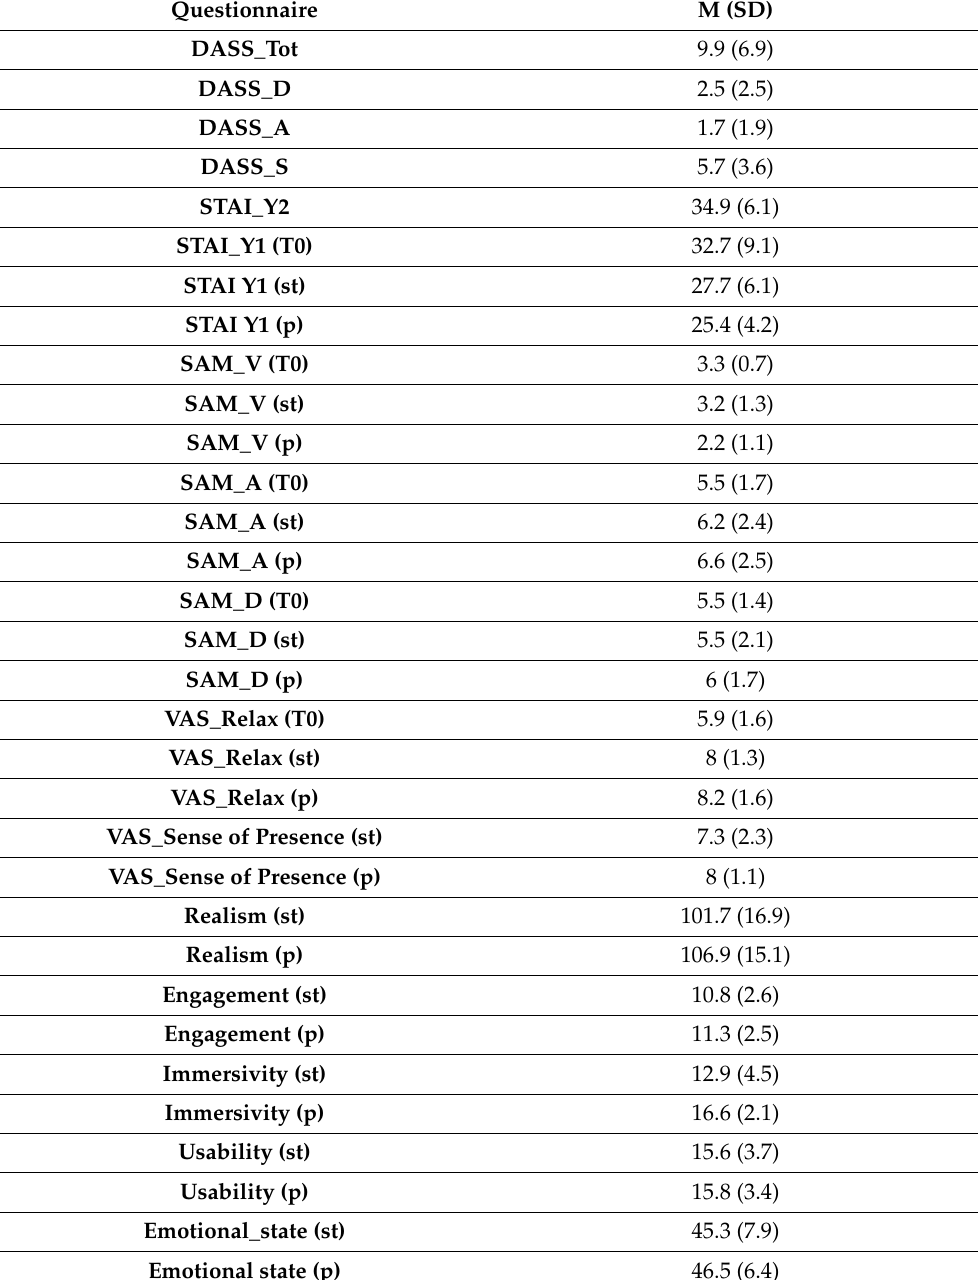
Table 3. Means and Standard Deviations related to self-report scales’